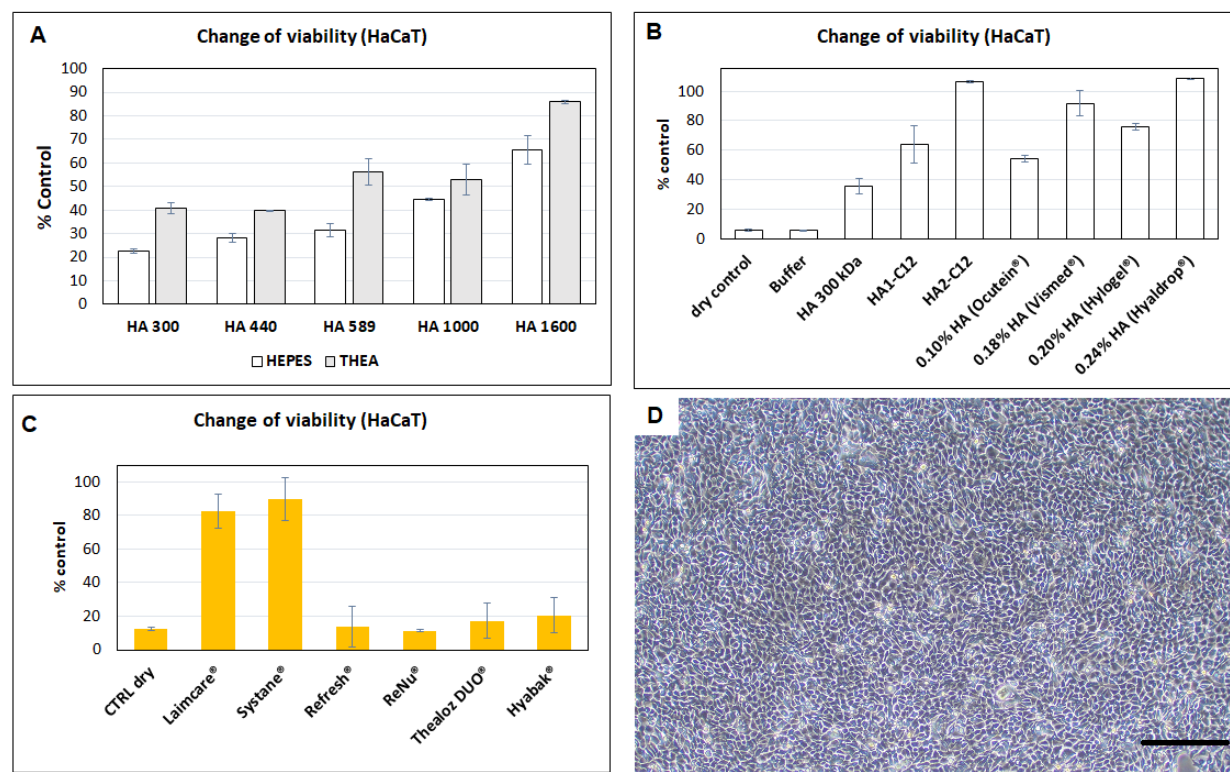
Figure 7. ( A ) The hydration-protection effect against desiccation after pre-treatment for HA (in HEPES or trehalose buffers) 0.3 wt.%. Results are mean ± SD, n = 3. ( B ) The hydration-protection effect against desiccation after pre-treatment for HA, HA2-C12 and OTC products. ( C )The hydration-protection against desiccation after pre-treatment with selected OTC products. The results are an average (mean value ± SD, n = 6) Significant differences ( p < 0.05) were compared to the control “dry cells” ( D ) Optical microscopic imagen of cell protection obtained for HA2-C12 (scale bar = 300 µm).